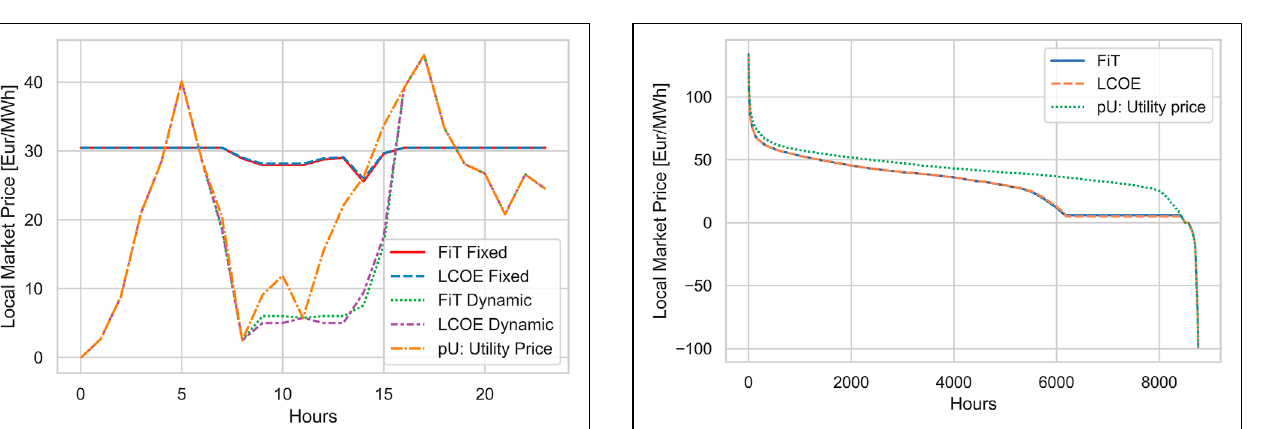
Frontiers in Energy Research |